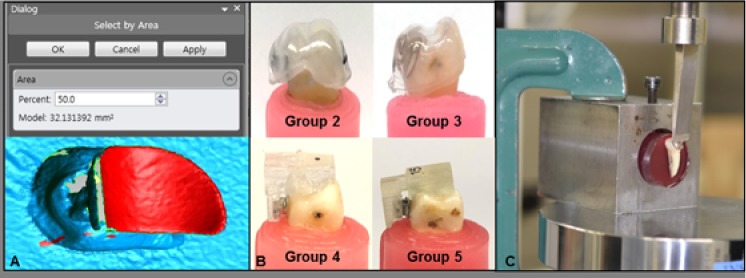
Bracket base calculation, indirect bonding and debonding force test.A. Measurement of bracket bonding area by 3D analysis program; B. Indirect bonding on tooth with transfer tray/jig; C. Measurement of debonding force by Instron machine.